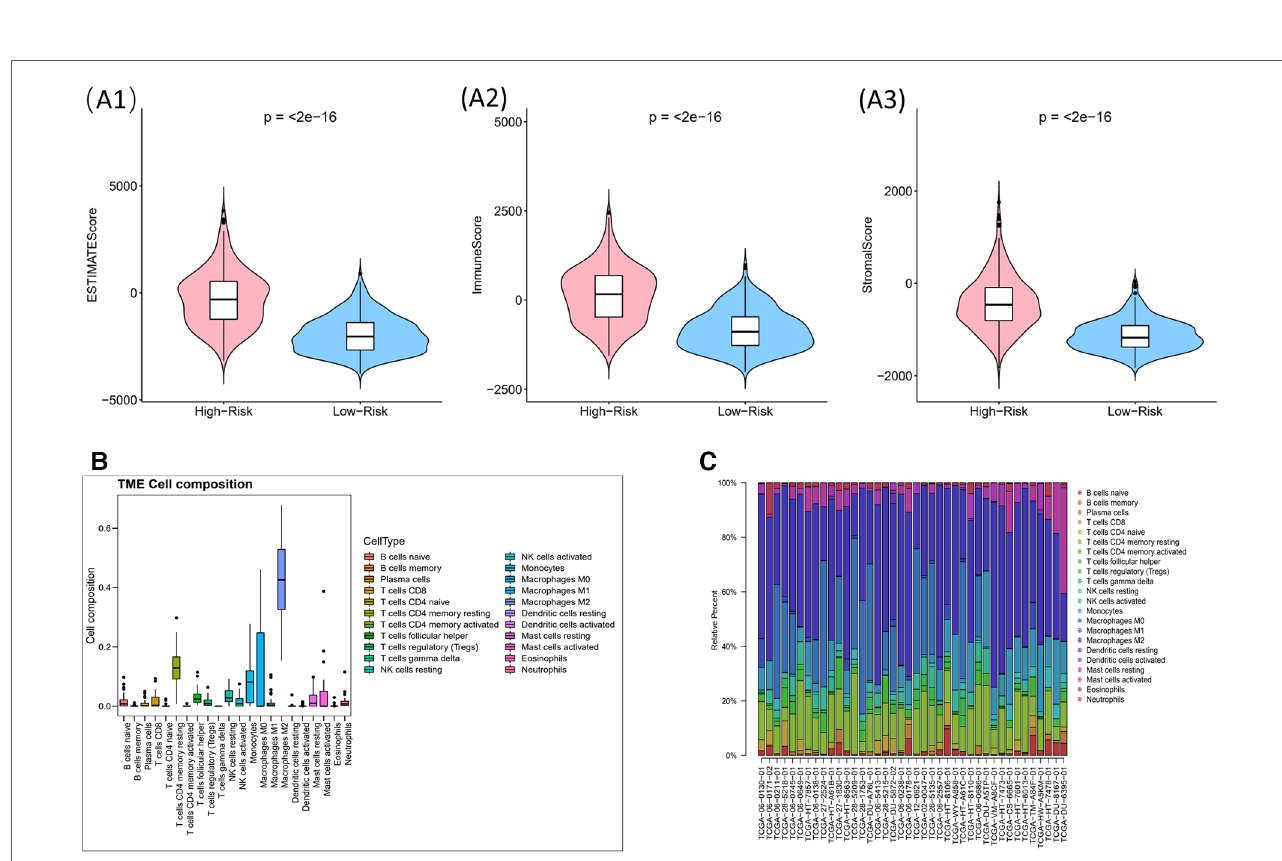
FIGURE 9 Impact of risk model on immune heterogeneity ( A ) violin diagram of immune scores, stromal scores and ESTIMATE scores for high and low risk groups. The horizontal coordinates represent the groupings (high-/low- risk groups) and the vertical coordinates represent the different scores, blue for the low risk group and pink for the high risk group. ( B,C ) The box line plots and stacked bar graphs show the abundance of immune